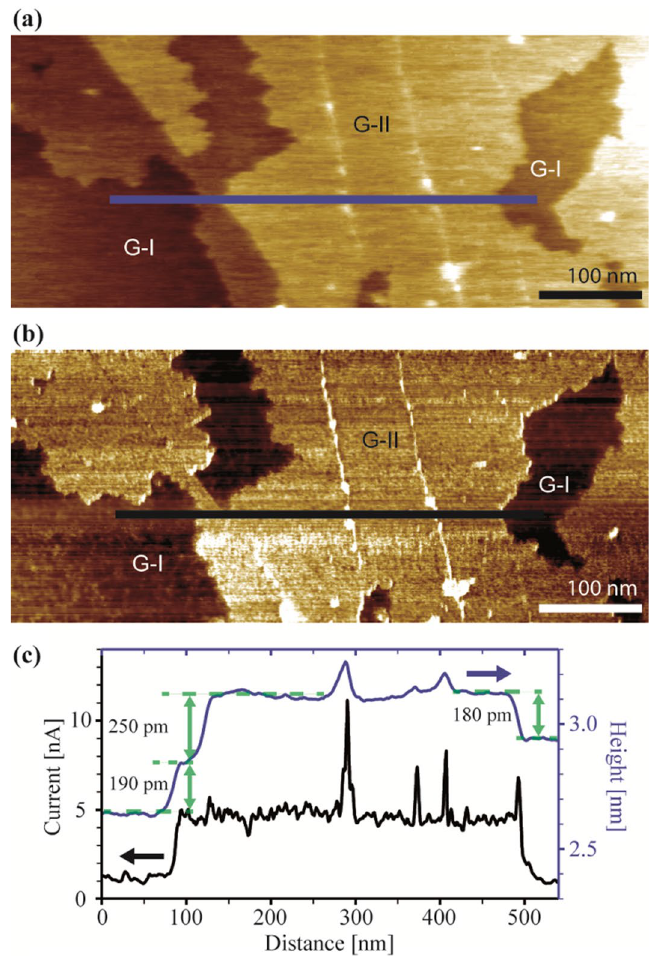
Figure 4. c-AFM measurements. ( a ) Topography image and ( b ) conductivity map of the same sample section. ( c ) Height (blue) and current (black) profiles along the bars indicated in ( a ) and ( b